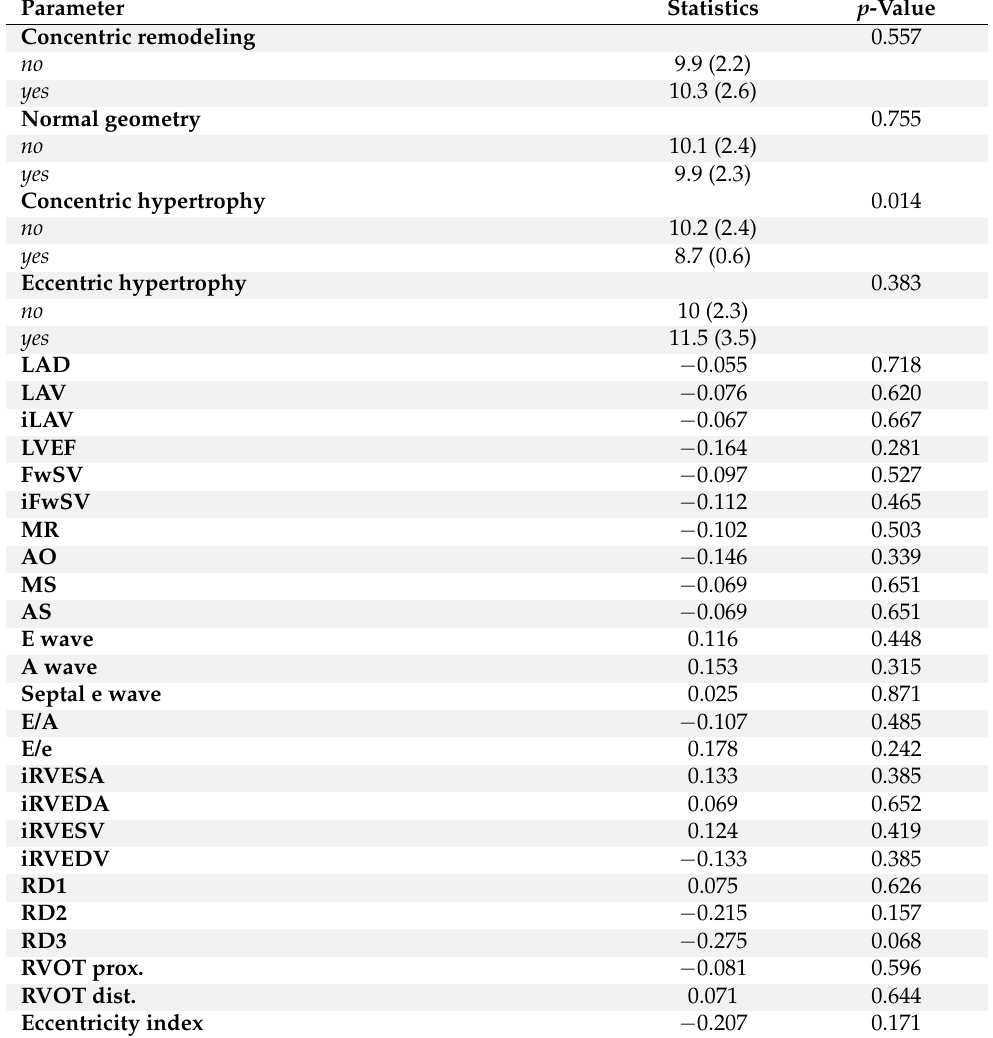
Table 3. Comparison between score and ultrasound